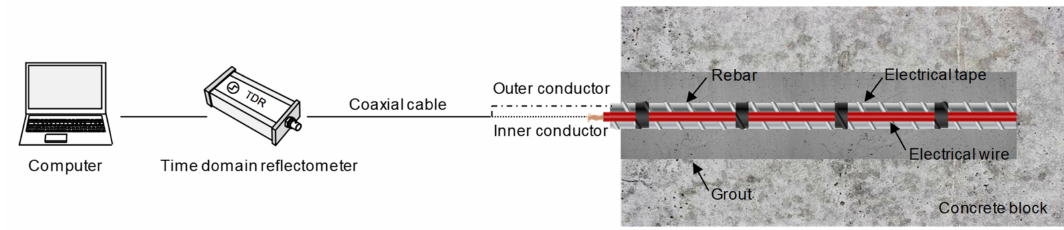
Figure 2. Smart sensing system for measuring electromagnetic waves in rock bolt.